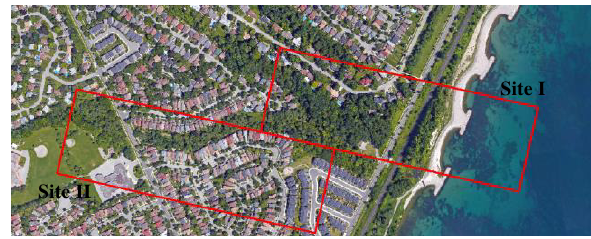
Figure 3. Google image showing Site I and Site II Since the number of points is not the same from each channel, the maximum number of points of the two input channels per each index was used in processing and displaying, in order to obtain highest point density. The points from green channel were used for NDFI G-NIR and NDFI G-MIR , while the points from NIR channel were used for NDFI NIR-MIR . The number of reference points for results validation, for each feature and total number, per each index are provided in Table 2 for the two sites.